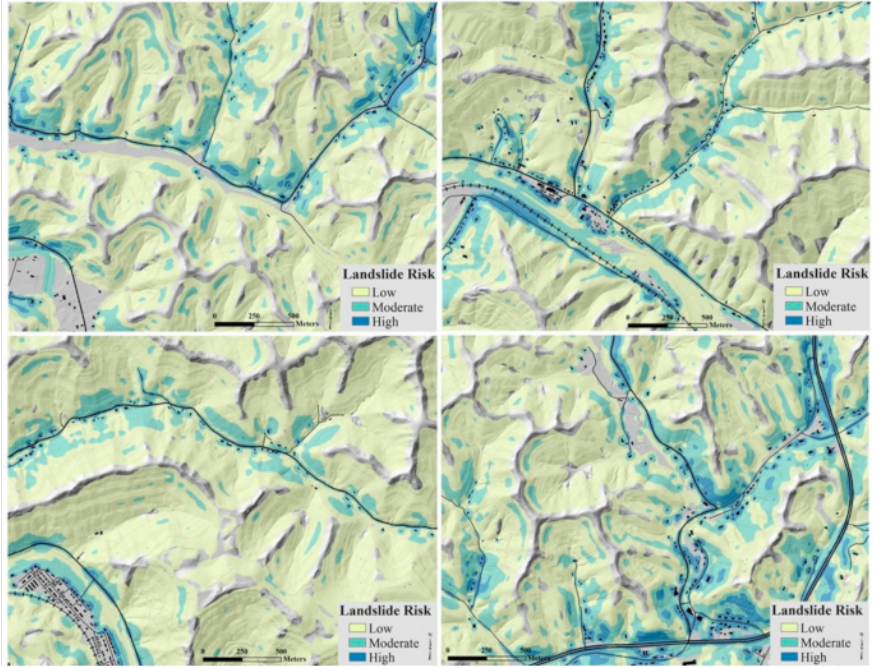
Figure 11. Risk map examples, Magoffin County ( upper left ), Pike County ( upper right ), Floyd County ( lower left ), and Johnson County ( lower right ). Black lines are roads, black polygons are buildings, and hatched lines are